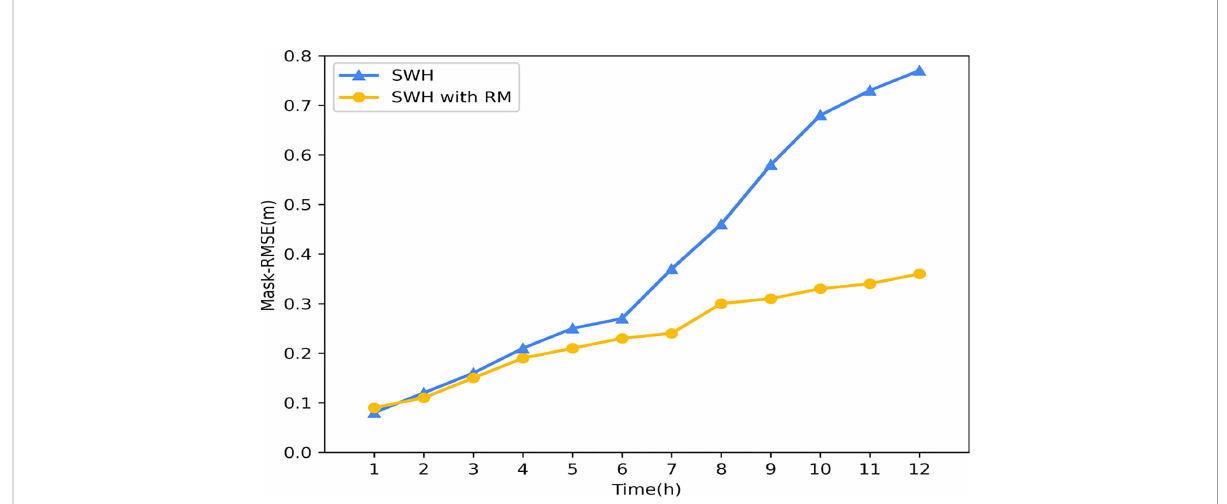
FIGURE 13 Comparison diagram of Mask-RMSE changes of the model before and after using the RM